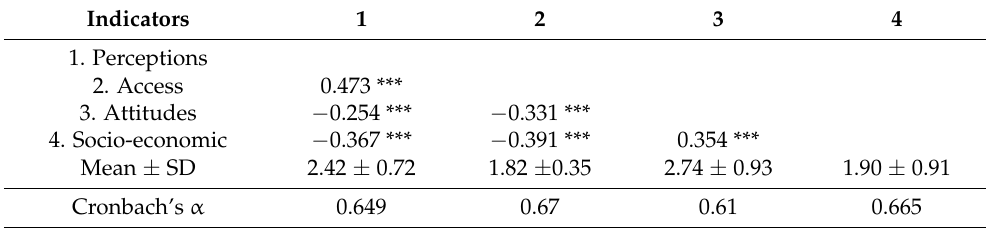
Table 5. Correlations analysis and internal consistency and